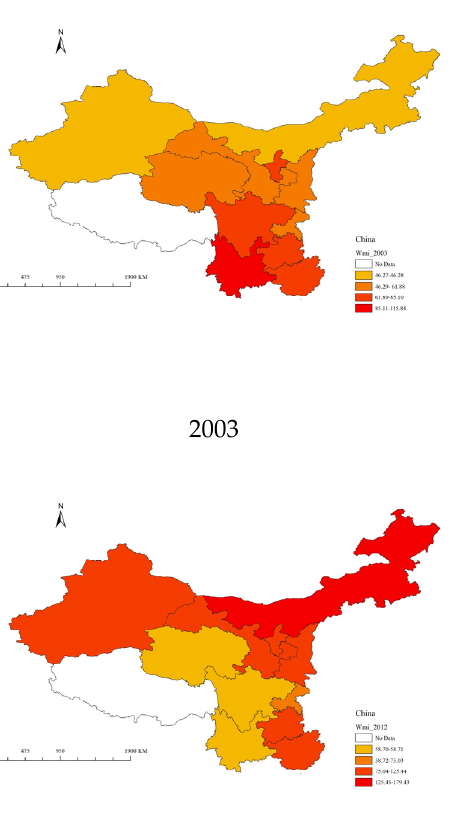
Figure 3. The level of market integration in central China.